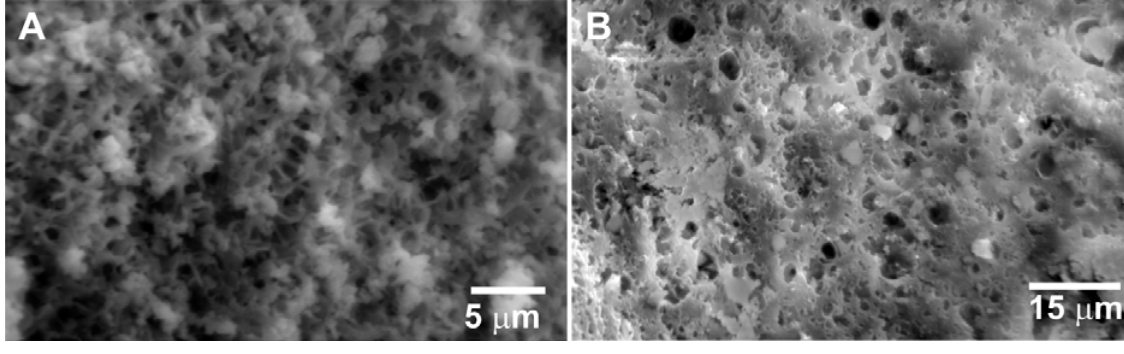
Figure 2. Scanning electron microscopy (SEM) images of HX ( A ) and CF ( B ) showing differing macroscale